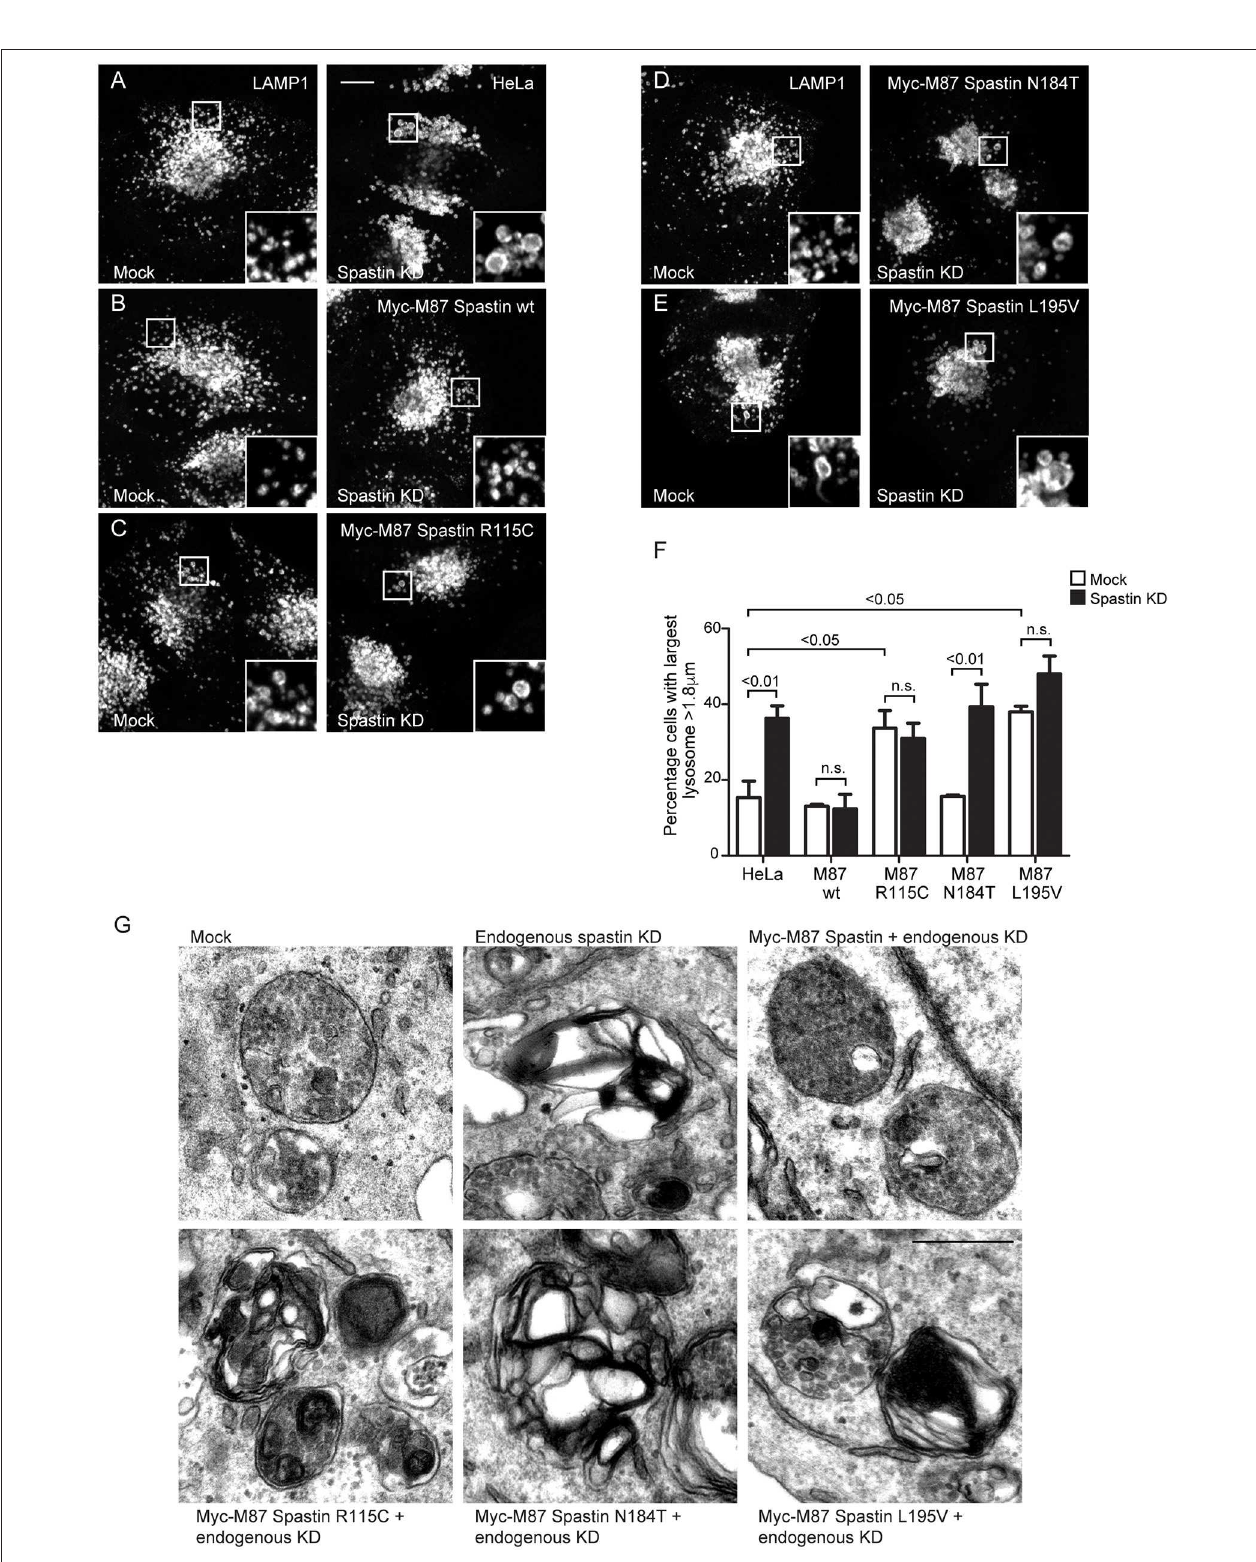
FIGURE 3 | Spastin MIT domain mutants cannot support normal lysosomal morphology. (A–E) Wild-type HeLa cells or cells expressing the siRNA-resistant spastin constructs indicated were subjected to mock transfection or siRNA-mediated KD of endogenous spastin, then processed for immunofluorescence microscopy and labeled for LAMP1. Insets show higher magnification views of the boxed areas. Scale bar = 10 µ m. (F) The diameter of the largest lysosome was measured in 100